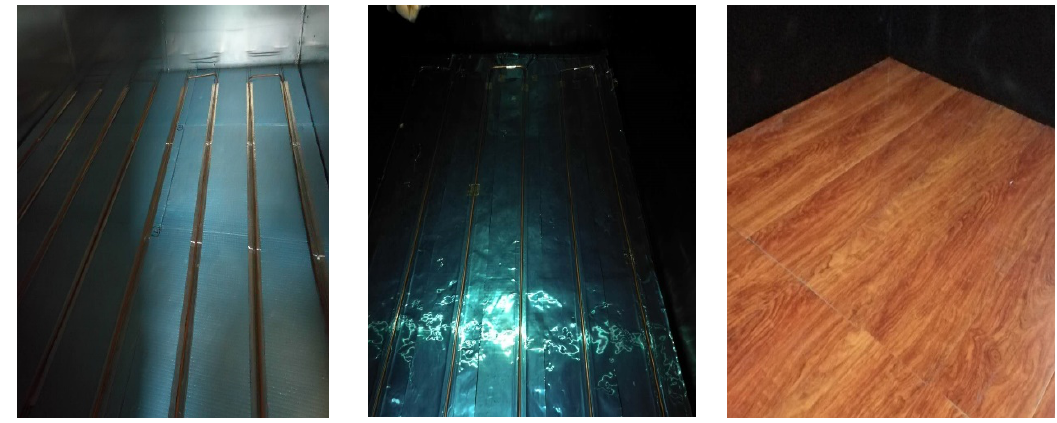
Figure 3. Photographs of the experimental heating terminal structure.